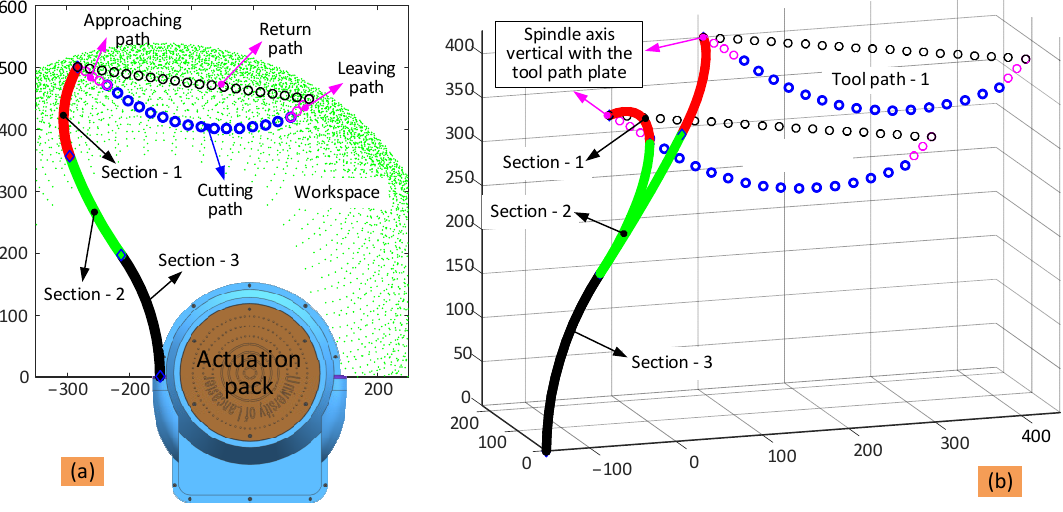
Figure 7. Toolpath planning strategy for the cutting operation in the sample removal case study: ( a ) is the toolpath definition (section view is selected); ( b ) is the overall view of the toolpath to show the configuration of the arm at different relative positions.